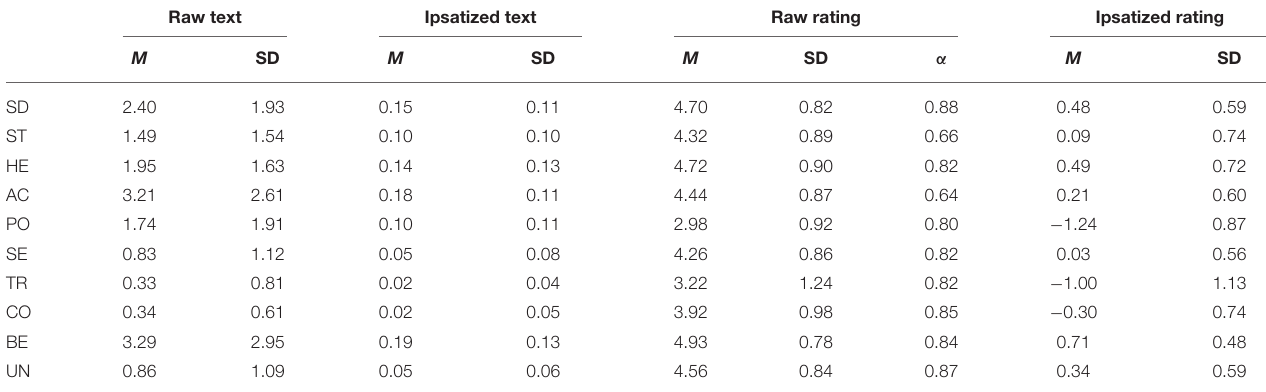
TABLE 9 | Overall mean ratings across data modalities in Study 3. Raw text Ipsatized text Raw rating